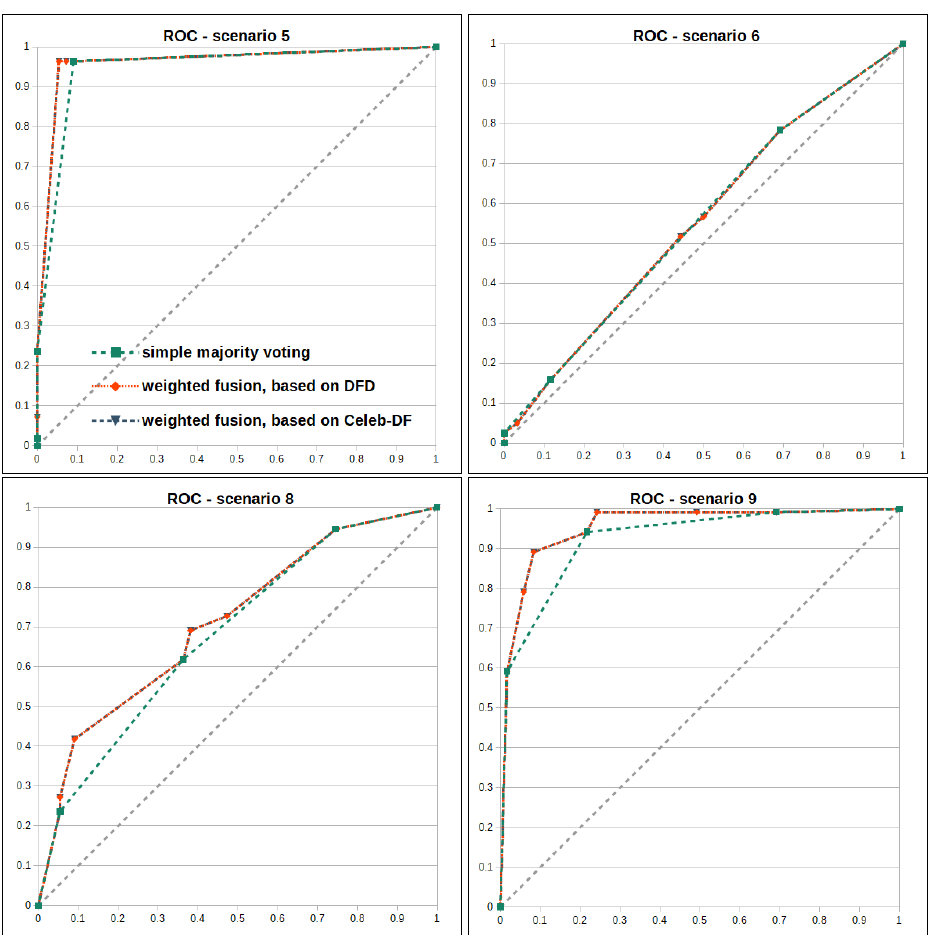
Figure 7. Receiver operation curves (ROCs) for the decision-level fusion methods simple majority voting and weighted fusion, based on DFD and Celeb-DF. Scenarios S5, S6, S8 and S9, which consider both the DFD and Celeb-DF datasets, are presented here. The false alarm rate (false positive rate) is plotted on the x-axis. The sensitivity (true positive rate) is plotted on the